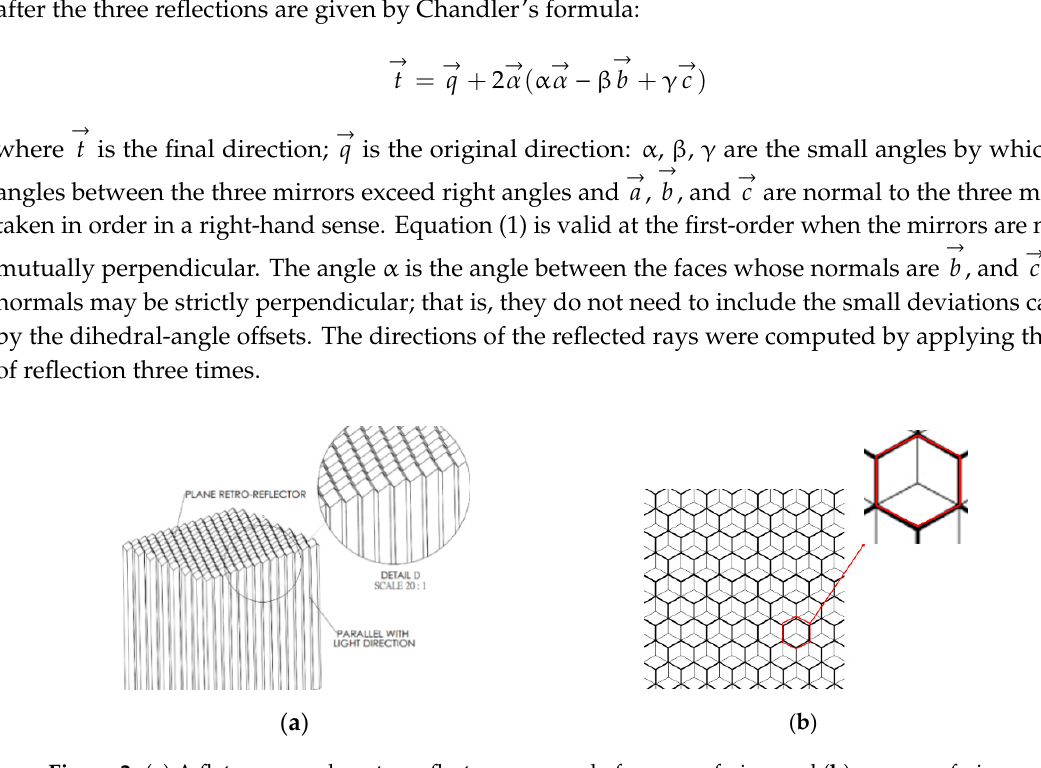
Figure 1. Retro-reflected light by ( a ) the Economic Commission for Europe (ECE) regular reflex reflector, and ( b ) the ECE SuperPin reflex reflector.